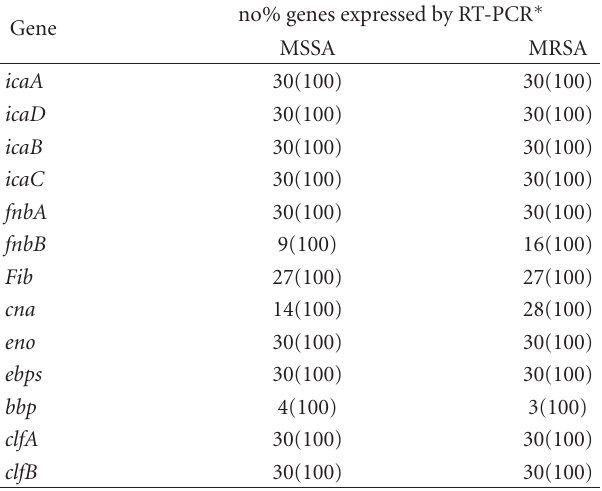
Table 3: MSCRAMM and biofilm gene expression levels of 60 MRSA and MSSA clinical isolates